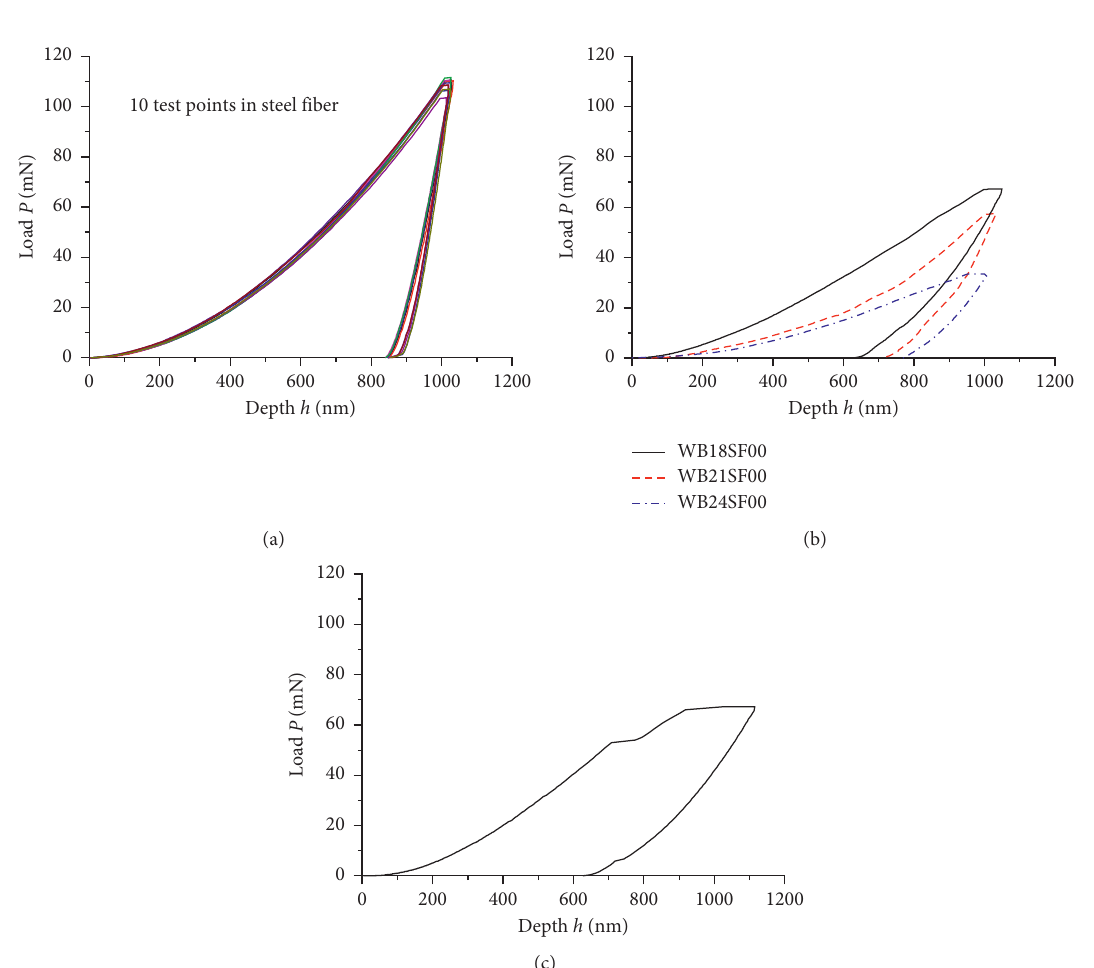
Figure 3: Load-depth curves of test points. (a) Load-depth curves of the test points in steel fiber. (b) Load-depth curves of test points in matrix 60 μ m away from the steel-fiber surface. (c) Irregular load-depth